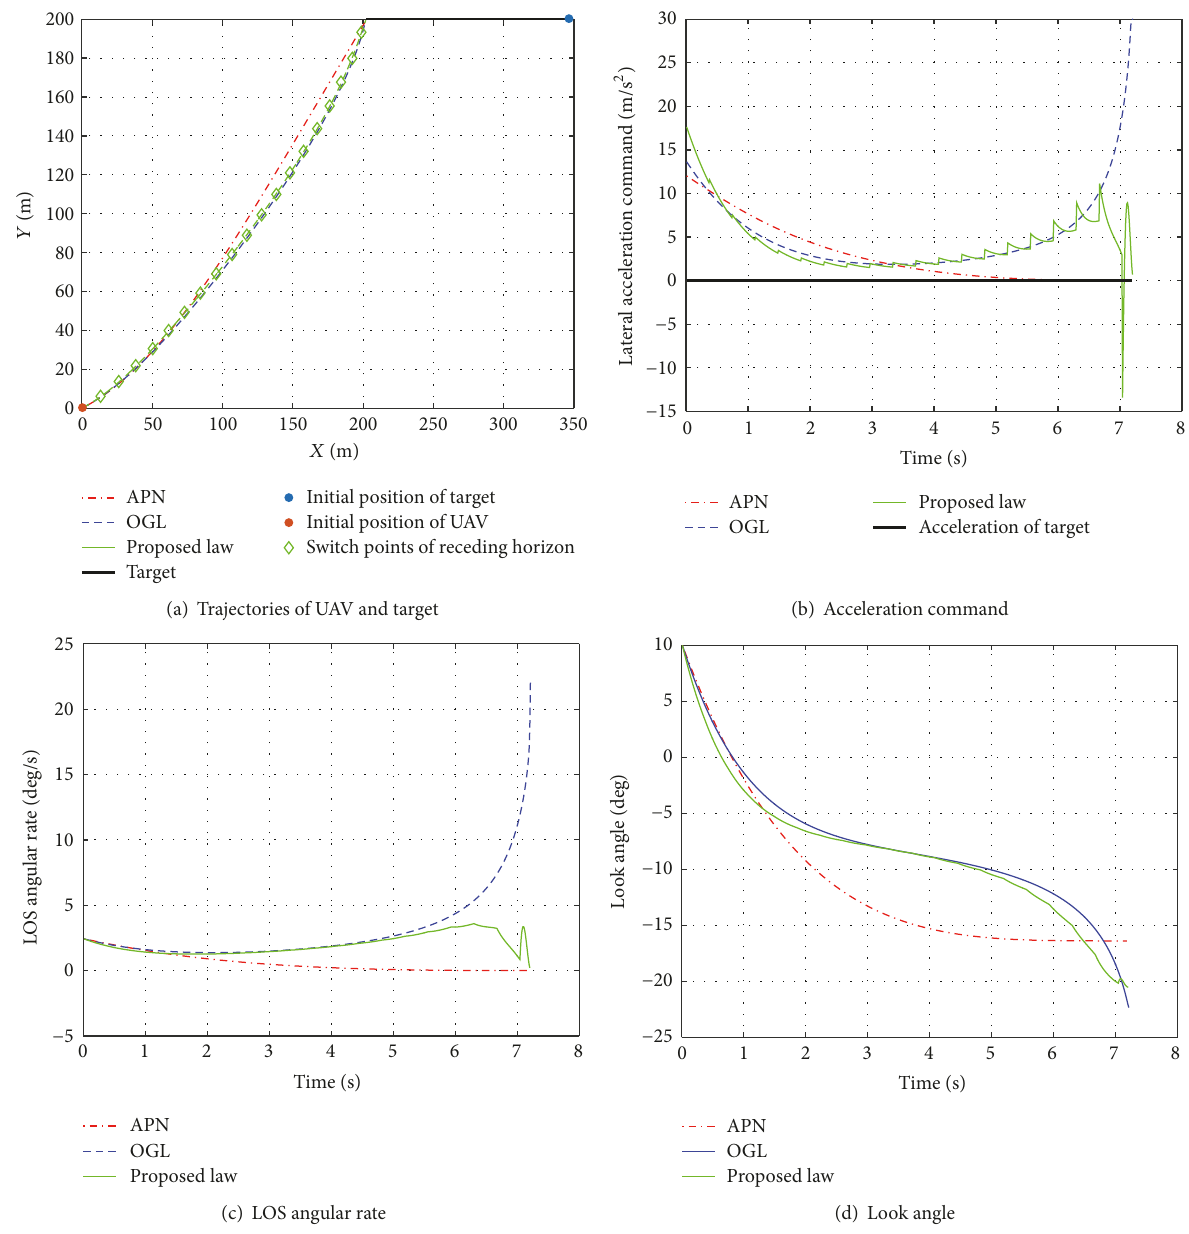
Figure 5: Responses in Case 1 (𝑎 𝑇 = 0 m / s 2 , 𝜃 𝑀0 = 180 ∘ )